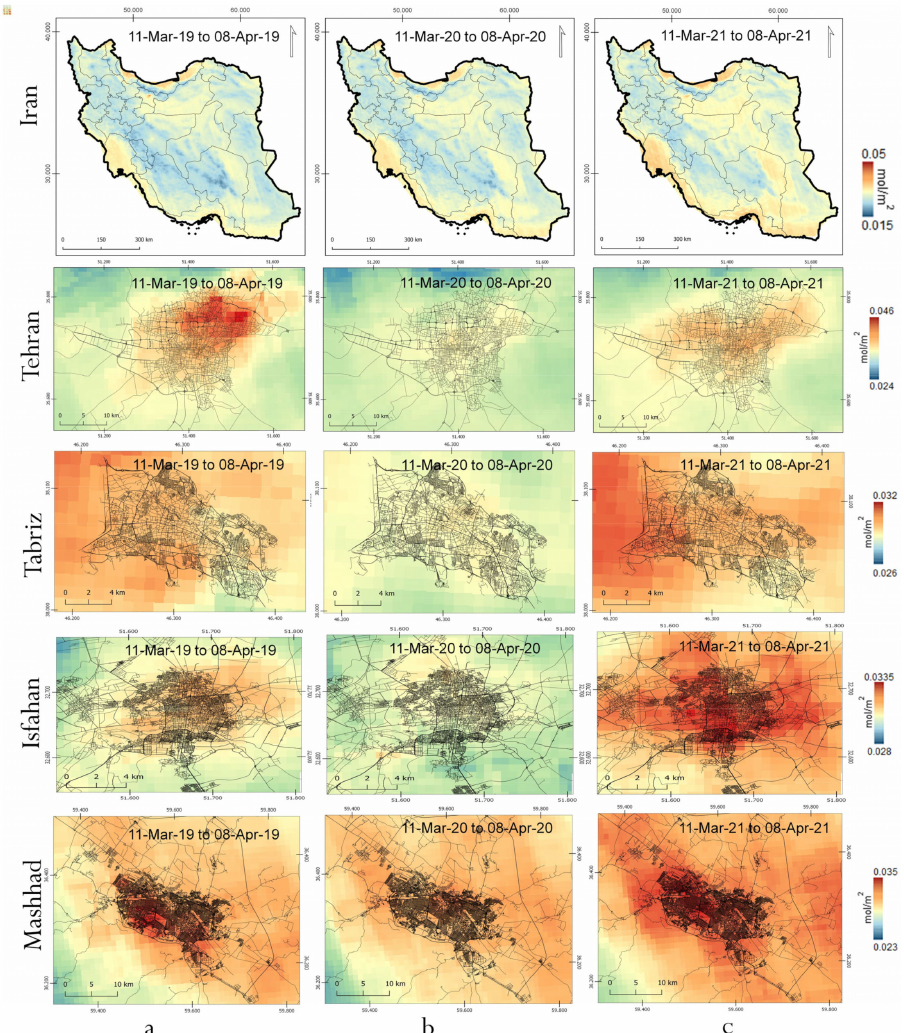
Figure 5. The comparative representations of the 30 day average CO over Iran (left column) and its four districts (Tehran, Tabriz, Isfahan, and Mashhad) (right column) during the period 11 March to 8 April in ( a ) 2019, ( b ) 2020, and ( c )